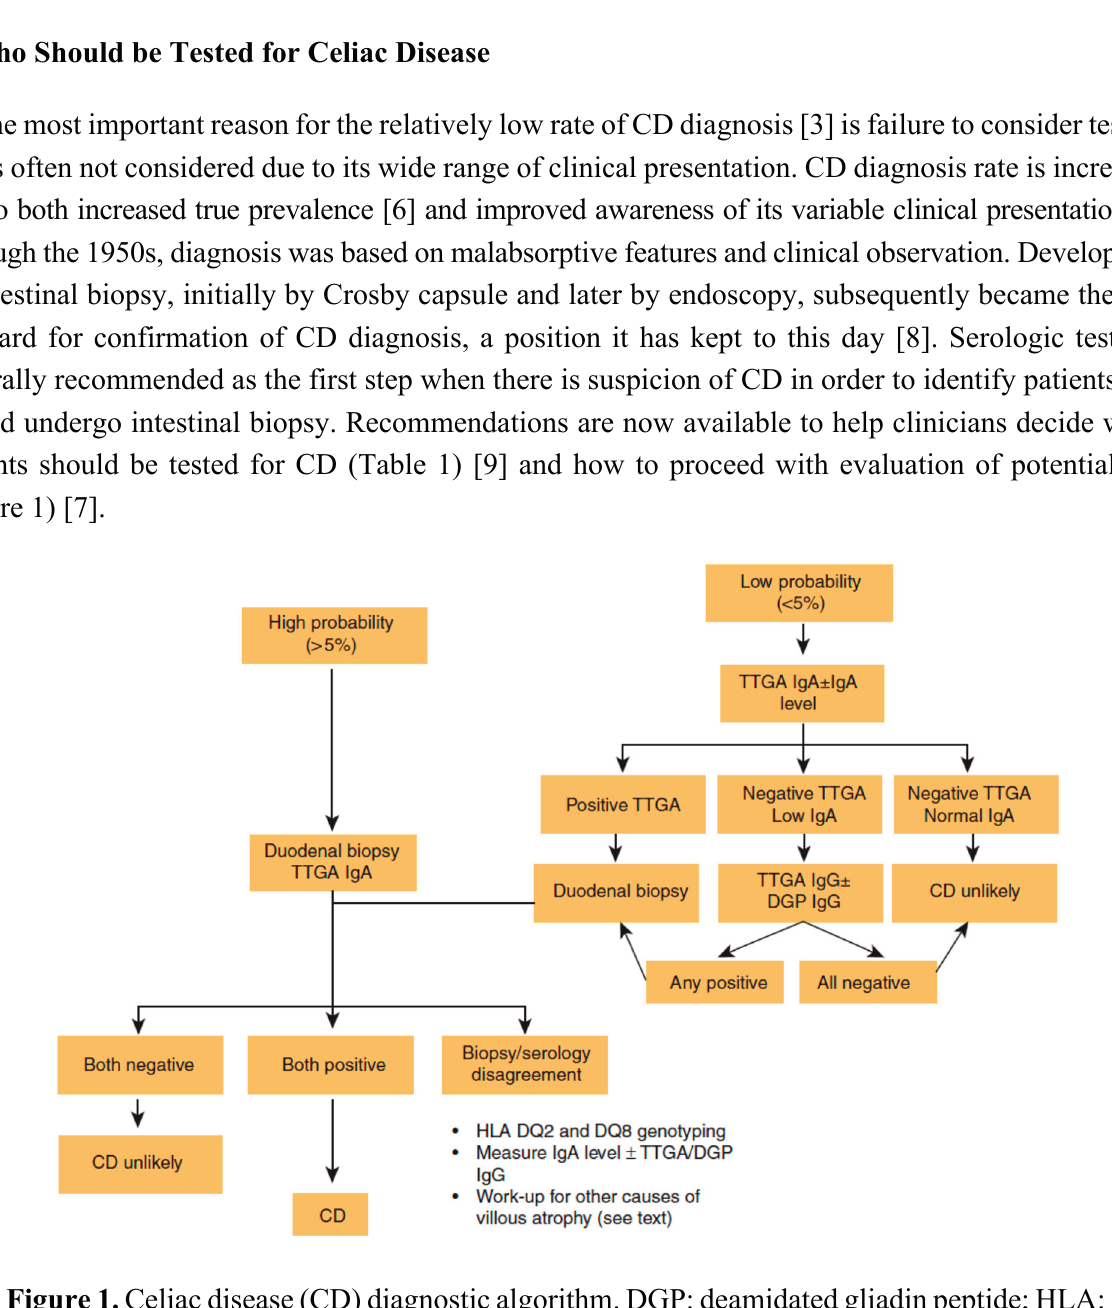
Figure 1. Celiac disease (CD) diagnostic algorithm. DGP: deamidated gliadin peptide; HLA: human leukocyte antigen; Ig: immunoglobulin; TTGA: tissue transglutaminase antibody [7]. Reproduced with permission from Kelly C.P. [7], (ACG clinical guidelines: Diagnosis and management of celiac